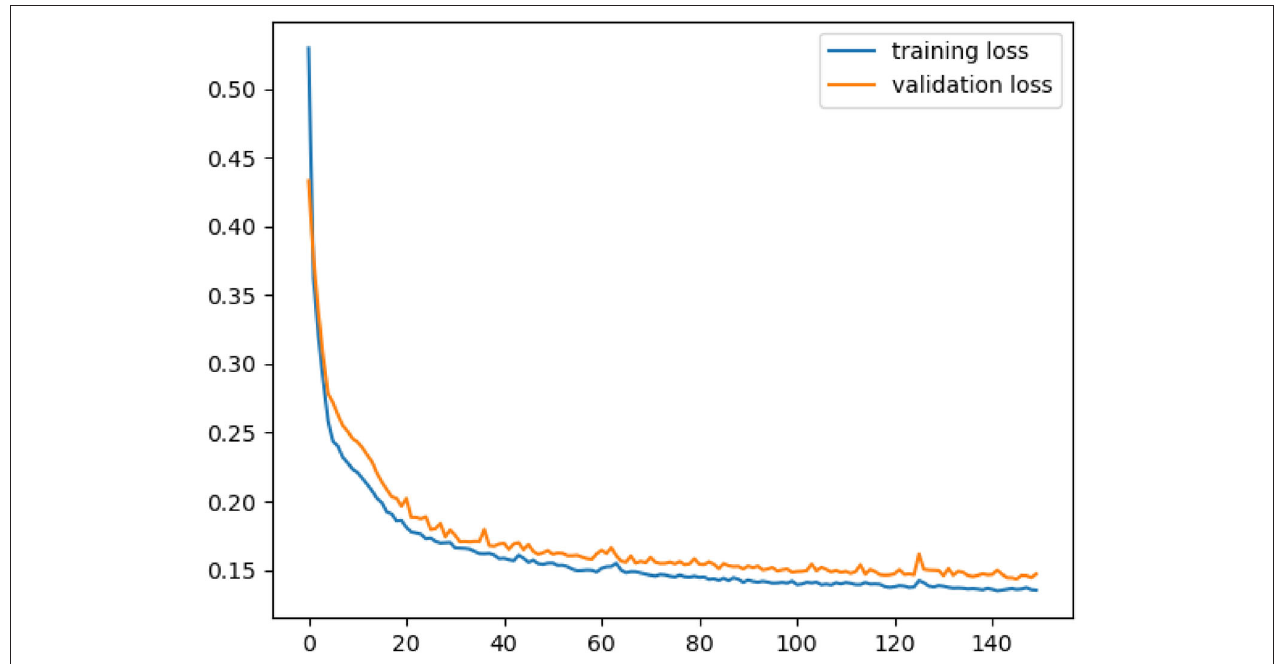
FIGURE 4 | Variation for training loss and validation